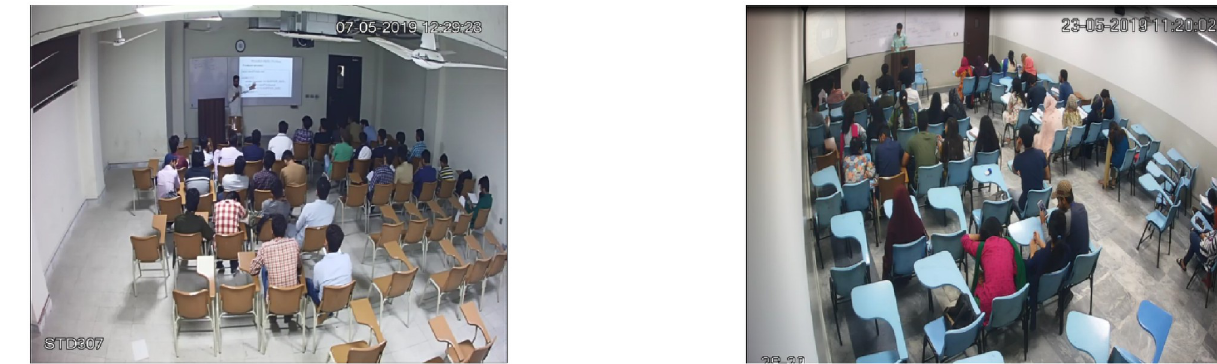
Fig 1. In this figure two sample images from the dataset are